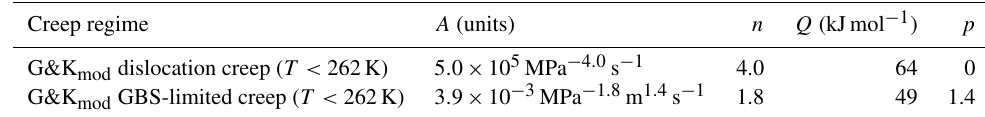
Table 2. Modified dislocation creep parameters for the composite flow law as derived from Fig. 7. The transition temperature is taken to be 262K (see Sects. 2.3 and